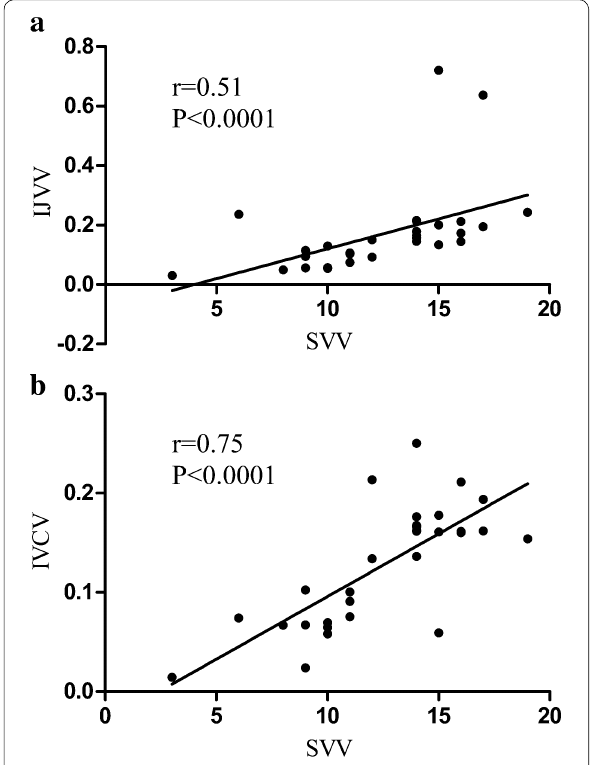
Fig. 2 Pearson correlation analysis. ( a , association between IJVV and SVV; b , association between IVCV and